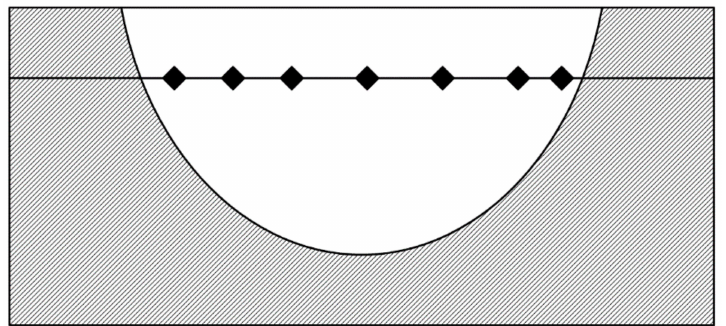
Figure 2. The position of the hardness measurement